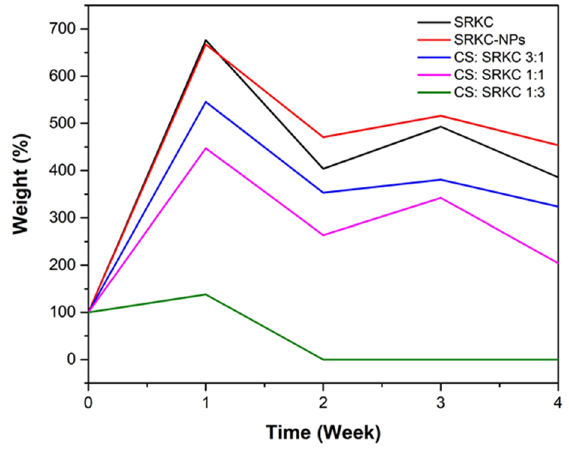
Figure 9. Degradability of bionanocomposite films.